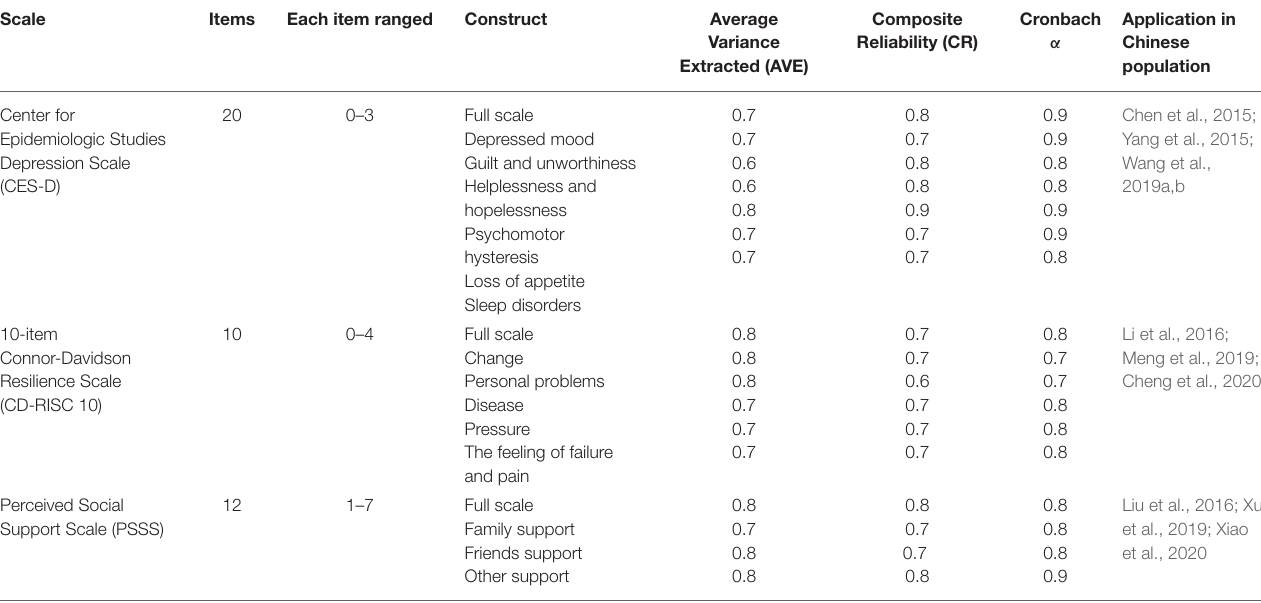
TABLE 1 | Details of the Center for Epidemiological Studies-Depression Scale (CES-D), 10-item Connor-Davidson Resilience Scale (CD-RISC 10), and Perceived Social Support Scale (PSSS). Scale